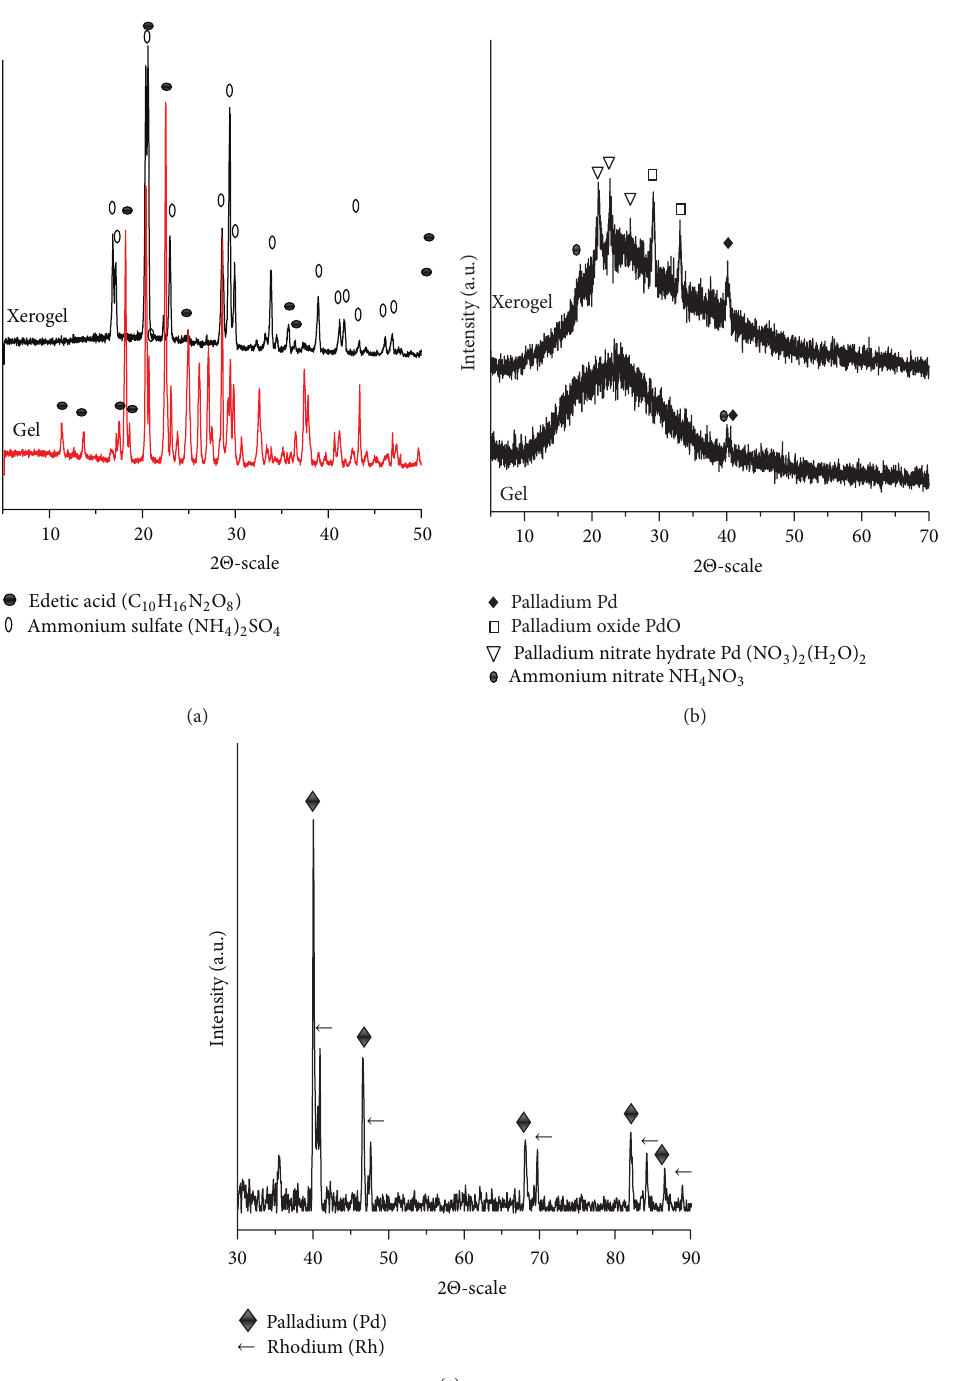
Figure 1: XRD patterns of (a) Rh, (b) Pd, and (c) bimetallic